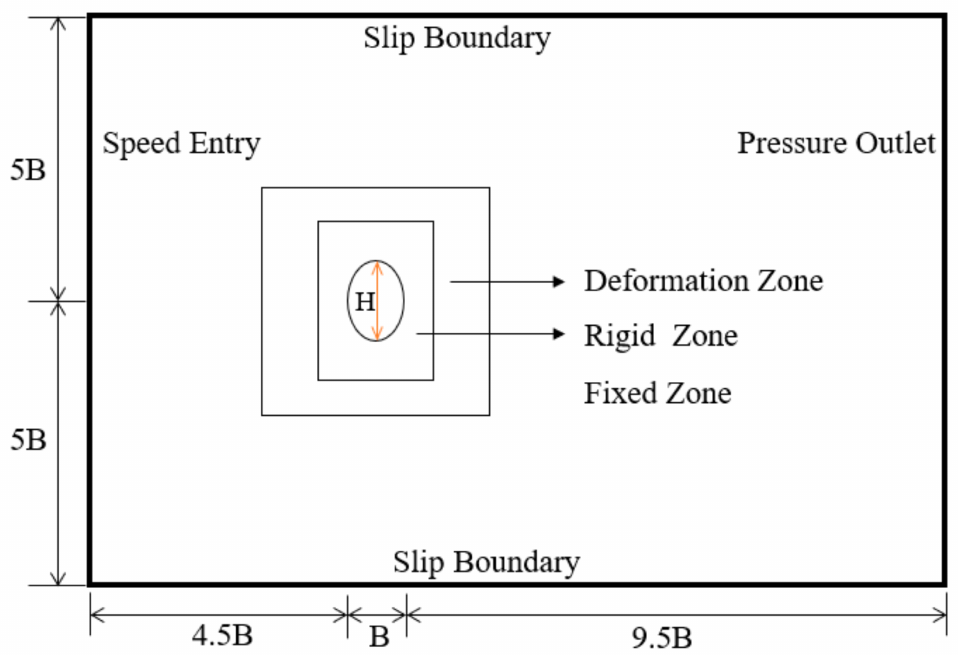
Figure 7. Sketch of the two-dimensional (2D) computational